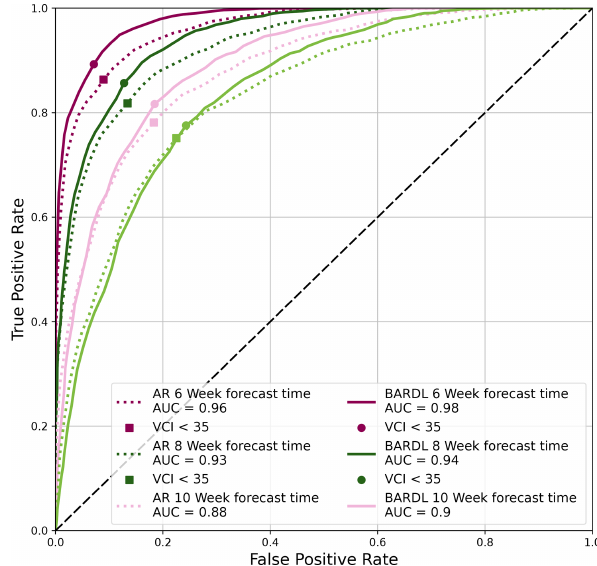
Figure 8. ROC curve showing true positive rate (TPR), false pos- itive rate (FPR), and AUC for 6-, 8-, 10-, and 12-week lead time for both AR (dotted line) and BARDL (solid line) models. The VCI3M < 35 threshold is plotted as points on the lines. The AUC scores for models was above 80%, indicating that both models were effective at identifying drought